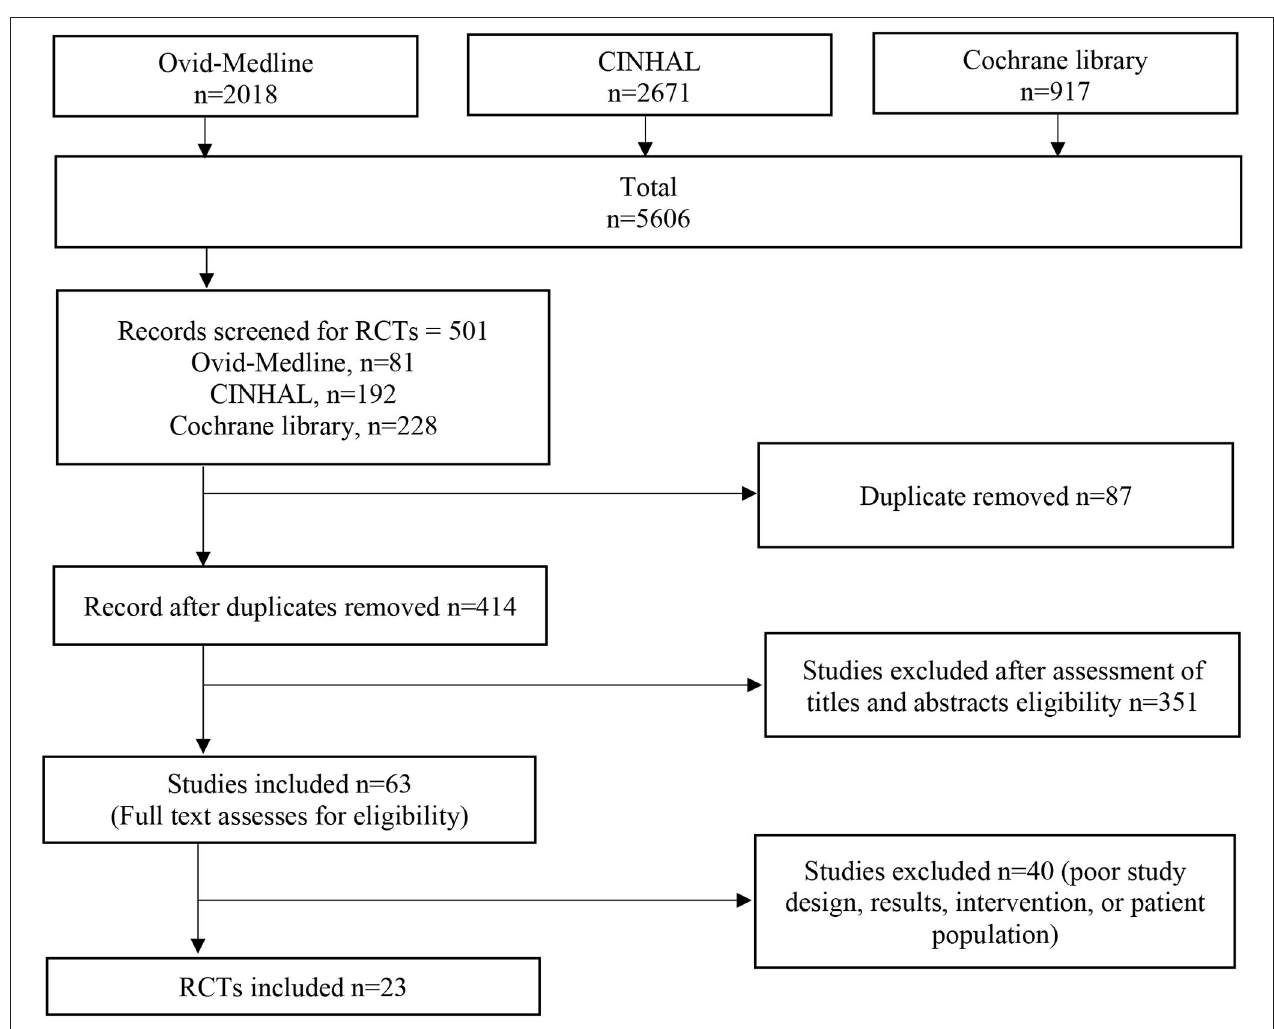
FIGURE 1 | Flow chart of literature